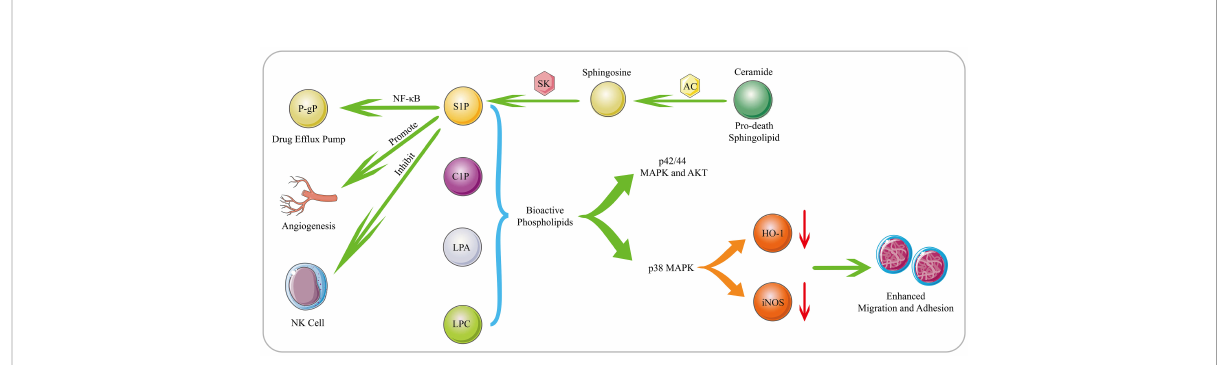
FIGURE 2 Biological Functions of Bioactive Phospholipids. S1P is generated through phosphorylation of sphingosine by SK. S1P mediates tumor cell proliferation, invasion, angiogenesis, drug resistance and immune escape. Moreover, AC can decompose the pro-death sphingolipid ceramide to generate sphingosine, which subsequently generates S1P. AC and S1P can activate the NF- k B pathway, and mediating the expression of the drug ef fl ux pump P-gp. The bioactive phospholipids such as S1P, C1P, LPC and LPA can stimulate the p42/44 MAPK and AKT signaling pathways. Moreover, as substances that can inhibit the migration of hematological cells, HO-1 and iNOS can be down-regulated by bioactive phospholipids in a p38 MAPK-dependent manner, thereby promoting the migration and adhesion of human leukemia